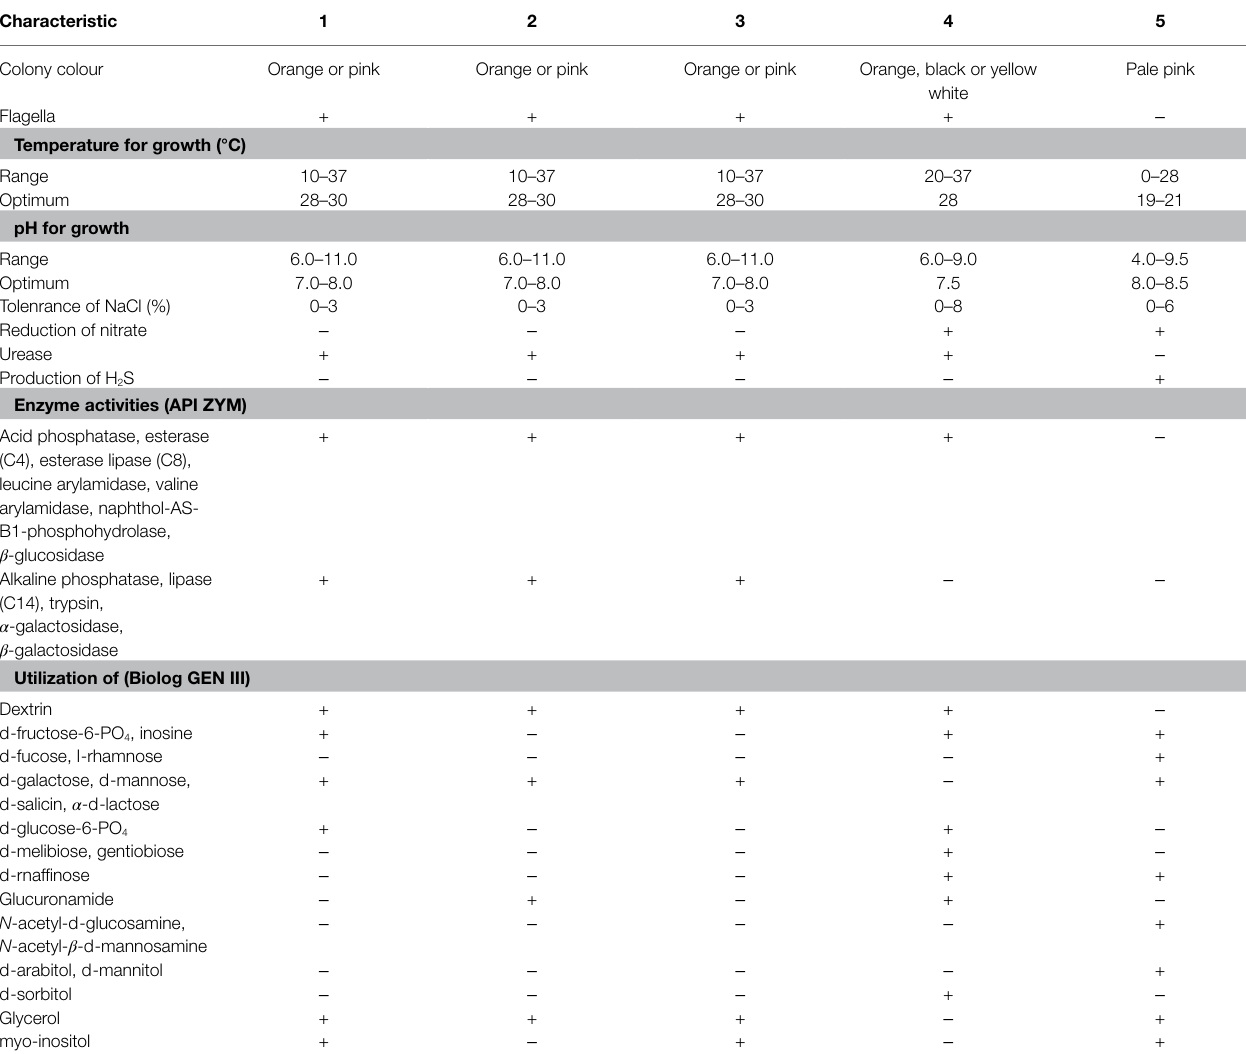
Pale pink white